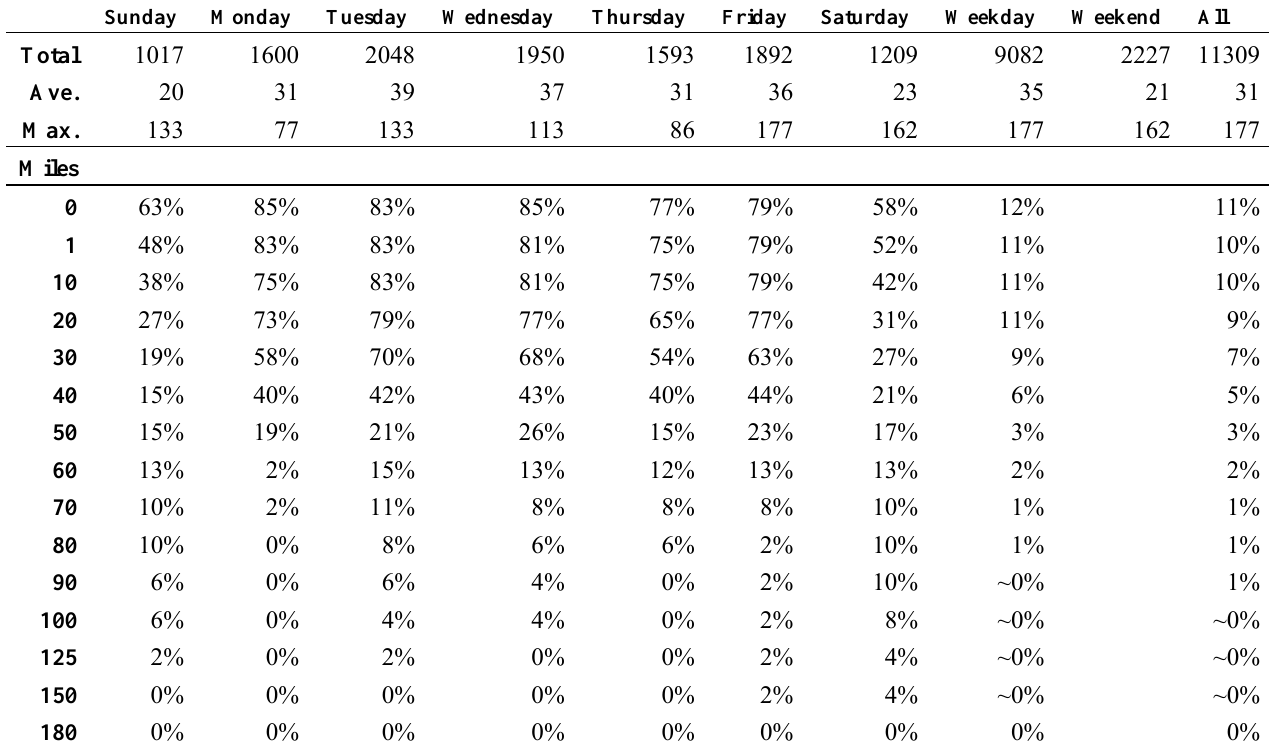
Table A-1. Daily driving distance (mi or % of days, all days ).